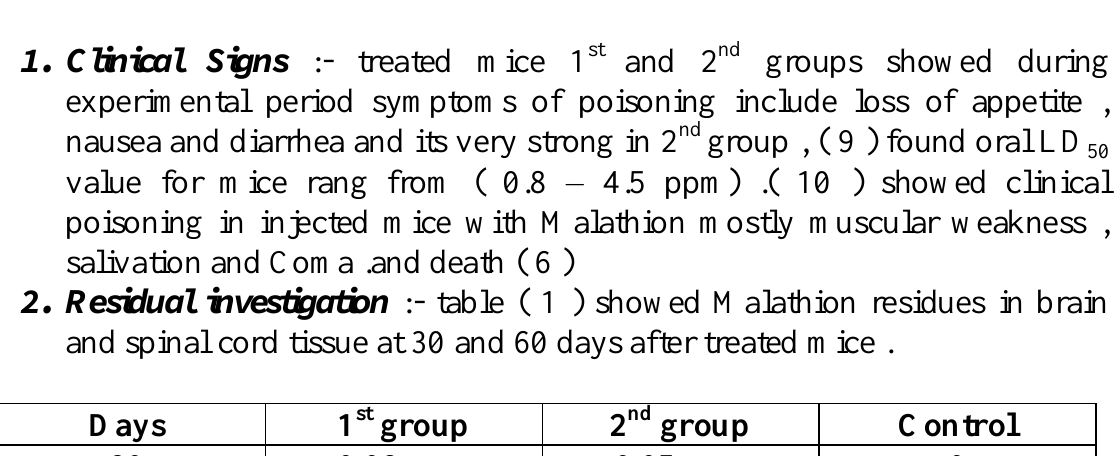
wweeaakknneessss ,, ssaalliivvaattiioonn aanndd ccoommaa ,, iittss ffoouunndd tthhaatt mmaallaatthhiioonn iiss nneeuurroottooxxiicc aaccttiioonn mmaayy bbee ccaauussee pprroossttrraattiioonn aanndd ddeeaatthh((66)).. MMaatteerriiaallss aanndd MMeetthhooddss AAnniimmaall ggrroouuppss :: 5500 wwhhiittee mmaallee mmiiccee wweerree uusseedd wweeiigghhttiinngg ((115500--117755 ggmm )) :: rraannddoommllyy wweerree ddiivviiddeedd iinnttoo 33 ggrroouuppss :: TThhee 11 sstt ggrroouupp ccoonnttaaiinn ((2200)) mmiiccee wweerree ggiivveenn aa ssiinnggllee oorraall ddoossee ooff 11..55 ppppmm mmaallaatthhiioonn iinn ddrriinnkkiinngg wwaatteerr ,, tthhee 22 nndd g g r r o o u u p p ( ( 2 2 0 0 ) ) m m i i c c e e w w a a s s g g i i v v e e n n 1 1 . . 5 5 p p p p m m m m a a l l a a t t h h i i o o n n i i n n d d r r i i n n k k i i n n g g w w a a t t e e r r a a t t 1 1 sstt , , 2 2 nndd a a n n d